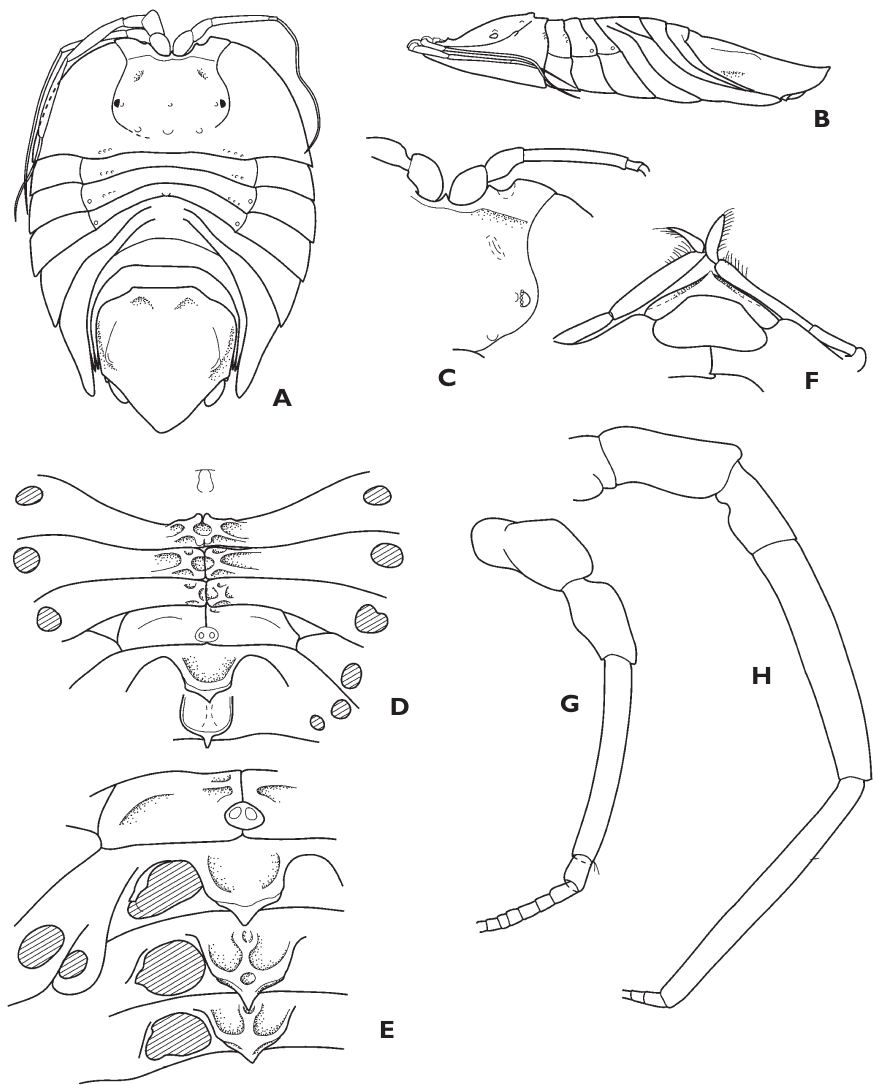
Figure 15. Myopiarolis norfanz sp. n. Holotype except E, paratype ♂ 10.7 mm. A dorsal view B lateral view C head, anterior margin D sternites and ventral pleonites E pleonites, ventral view F frons G antenna H